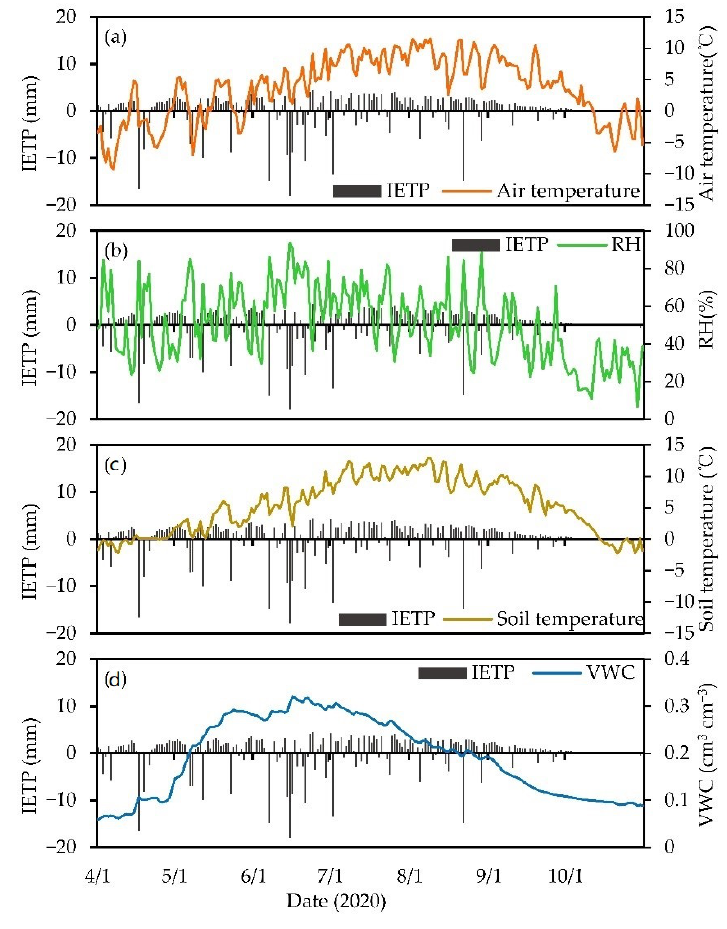
Figure 8. Trends of IETP and meteorological factors, including: ( a ) air temperature; ( b ) relative humility (RH); ( c ) soil temperature; and ( d ) soil volume water content (VWC), in